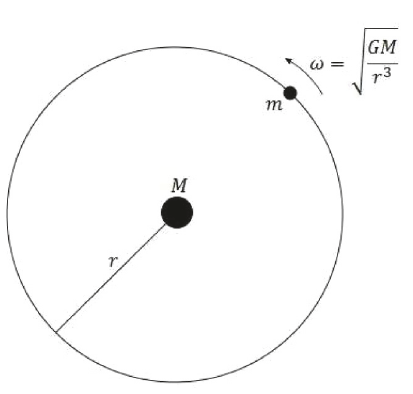
Figure 1: Greenberger classical gravitational Bohr atom with circu- lar